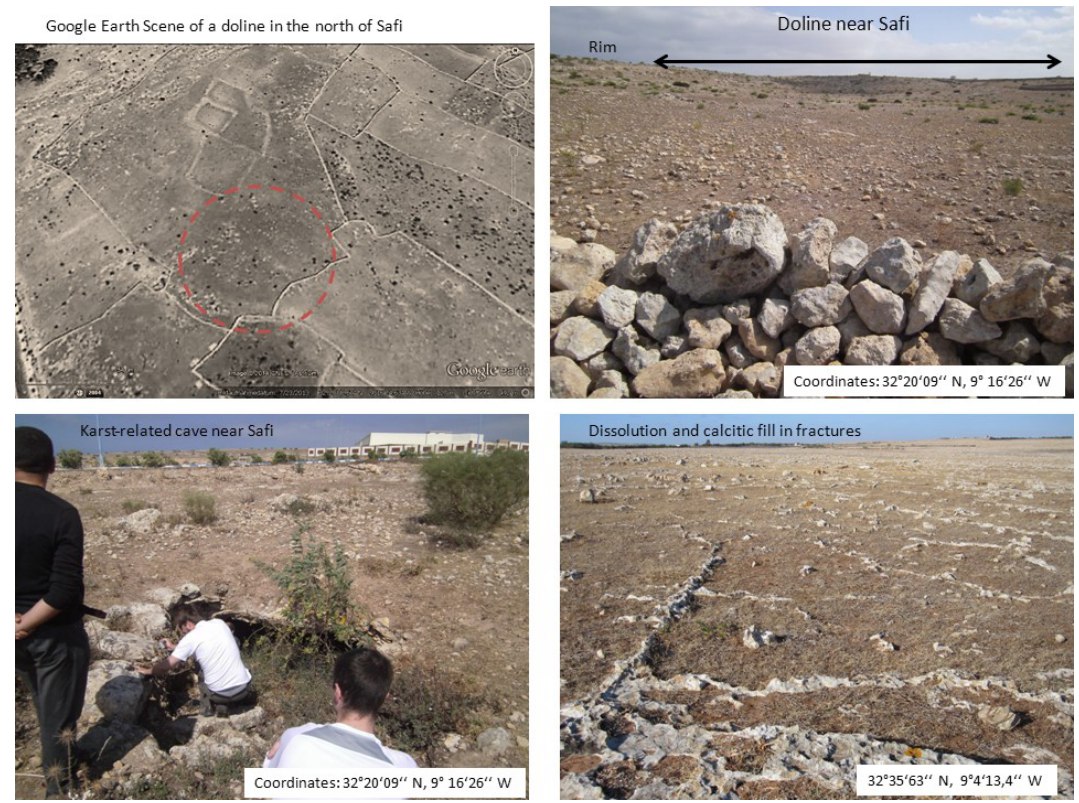
Figure 6. A doline of about 50 m in diameter in the north of